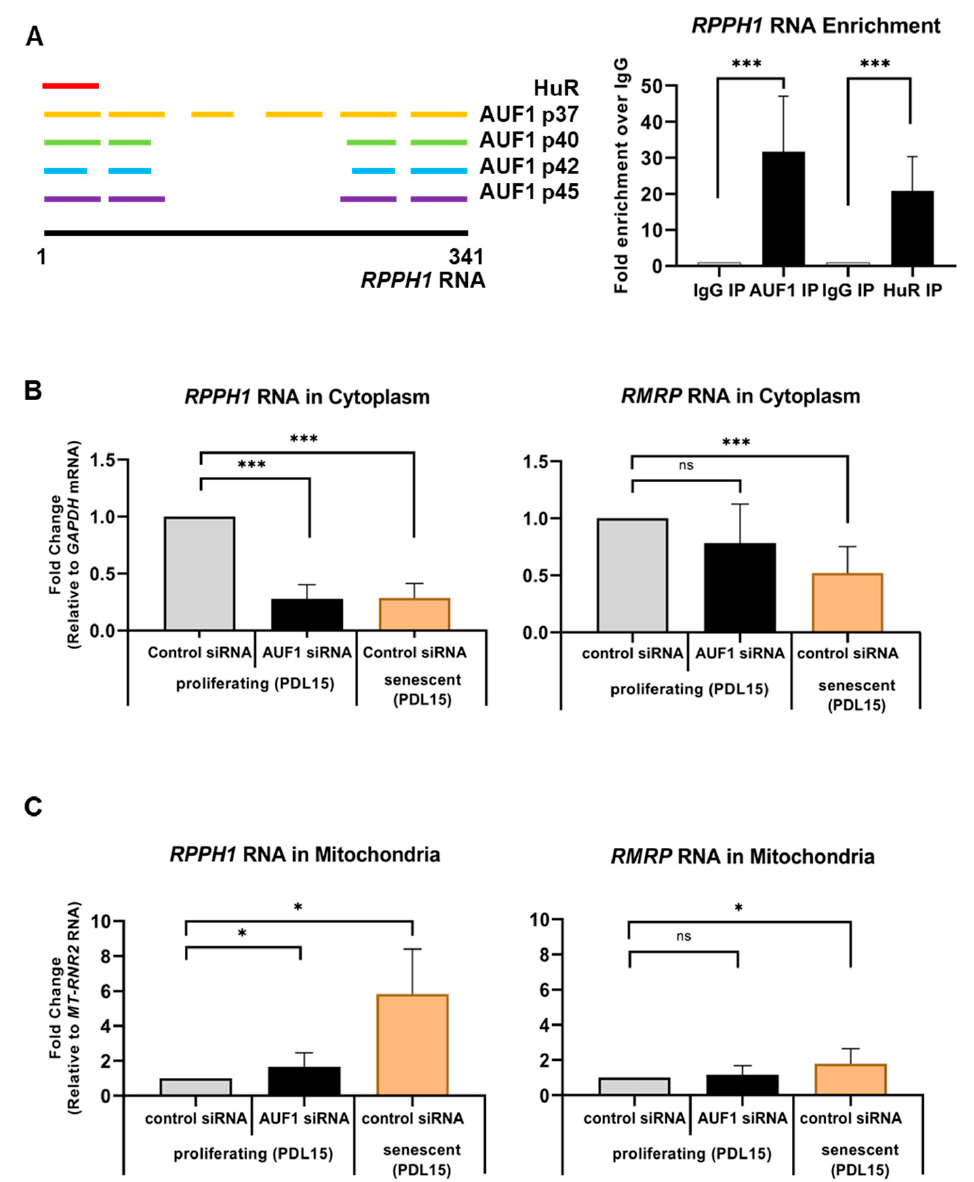
Figure 2. Mitochondrial accumulation of RPPH1 RNA is regulated by AUF1. ( A ) AUF1 and HuR binding sites on RPPH1 RNA identified from PAR-CLIP analysis. RIP analysis showing relative enrichment of RPPH1 RNA in AUF1 or HuR immunoprecipitation compared to IgG control in WI-38 cells as measured by whole cell RT-qPCR and normalized to GAPDH mRNA levels. ( B ) Relative expression of RPPH1 (left) and RMRP (right) RNAs in cytoplasm of proliferating (control or AUF1-silenced) or senescent WI-38 cells measured by RT-qPCR normalized with GAPDH mRNA. ( C ) Relative expression of RPPH1 (left) and RMRP (right) RNAs in mitochondria of proliferating (control or AUF1-silenced) or senescent WI-38 cells measured by RT-qPCR normalized with 16S rRNA, MT-RNR2 . Data in ( A – C ) are average +/ − S.D of independent three experiments. Asterisks denote statistical significance (Student’s t test): ns p > 0.05, * p ≤ 0.05, *** p ≤